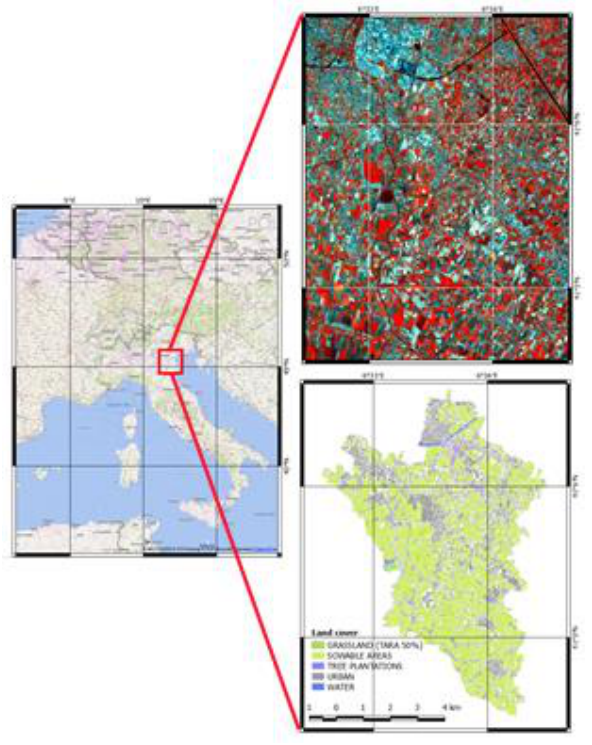
Figure 1. The satellite image (above) and land use map (below) of the study area.